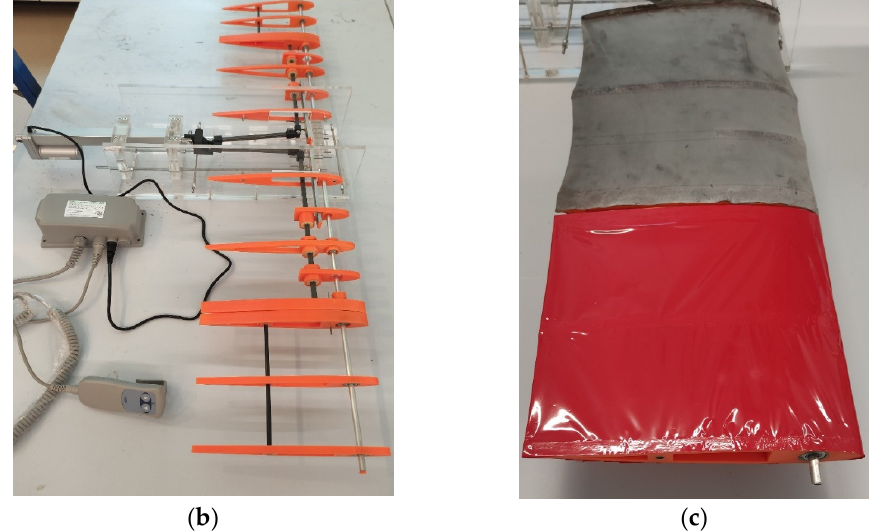
Figure 20. Assembled ASAPP wing: ( a ) Actuation system components. ( b ) ASAPP wing without skin. ( c ) Latex and MonoKote film attached.